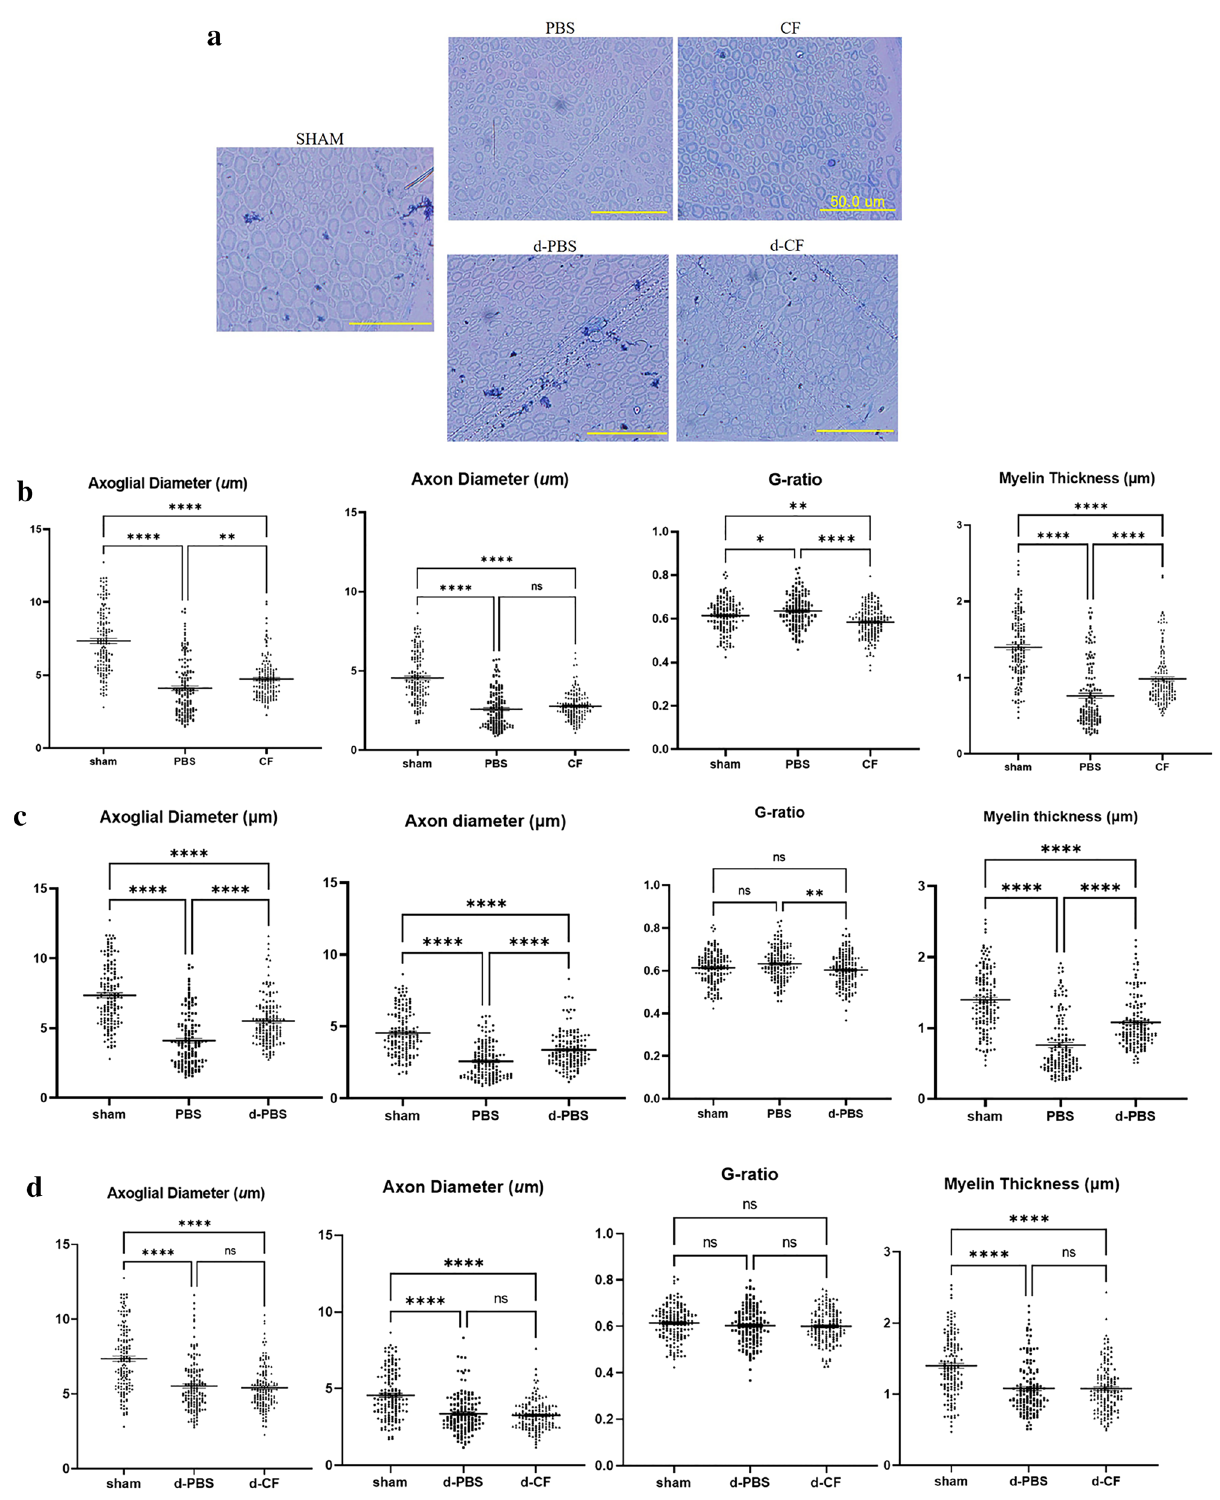
Figure 3. Representative cross-sectional images of the sciatic nerve upon toluidine blue staining in the compression and decompression phase ( a ) (× 400; scale bar = 50 μm; Sham, nerves of sham-operated mice; PBS, nerves of untreated mice during compression phase; CF, nerves of mice treated with clemastine during compression phase; d-PBS, nerves of untreated mice after surgical decompression; d-CF, nerves of mice treated with clemastine after surgical decompression). Comparison of the axoglial diameter, the axonal diameter, the G-ratio and the myelin thickness among sham, PBS, and CF group in compression phase ( b ). Comparison of these measurements among sham, PBS, and d-PBS group for evaluation of decompression effect ( c ). Comparison of these measurements among sham, d-PBS, and d-CF group in decompression phase ( d ). Error bars represent standard error of mean. One-way ANOVA with Turkey’s post-hoc test was conducted (*p < 0.05, **p < 0.01, ***p < 0.001, ****p < 0.0001, and n = 300 axons from 3 animals per